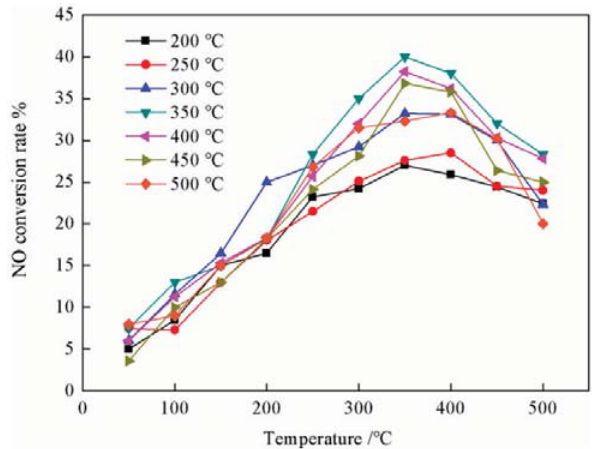
Figure 6: Comparison the denitrification rate for the microwave roasting and the muffle roasting at different